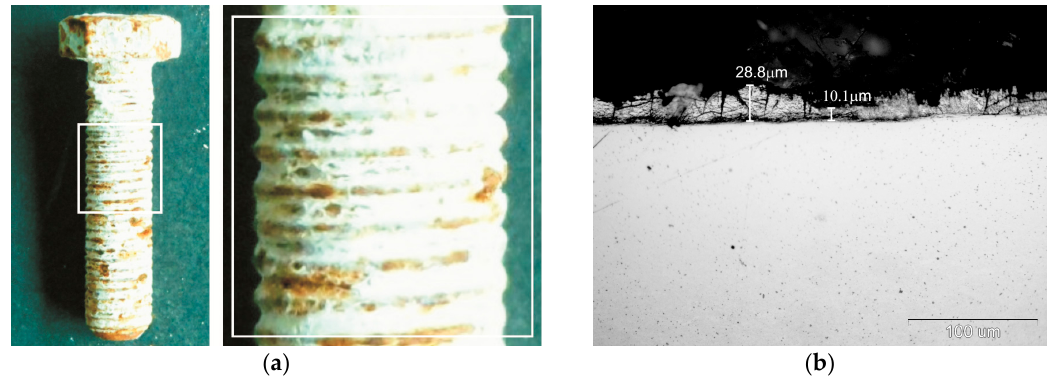
Figure 5. The appearance ( a ) and structure ( b ) of the thermal diffusion zinc coating after corrosion tests in a salt chamber.